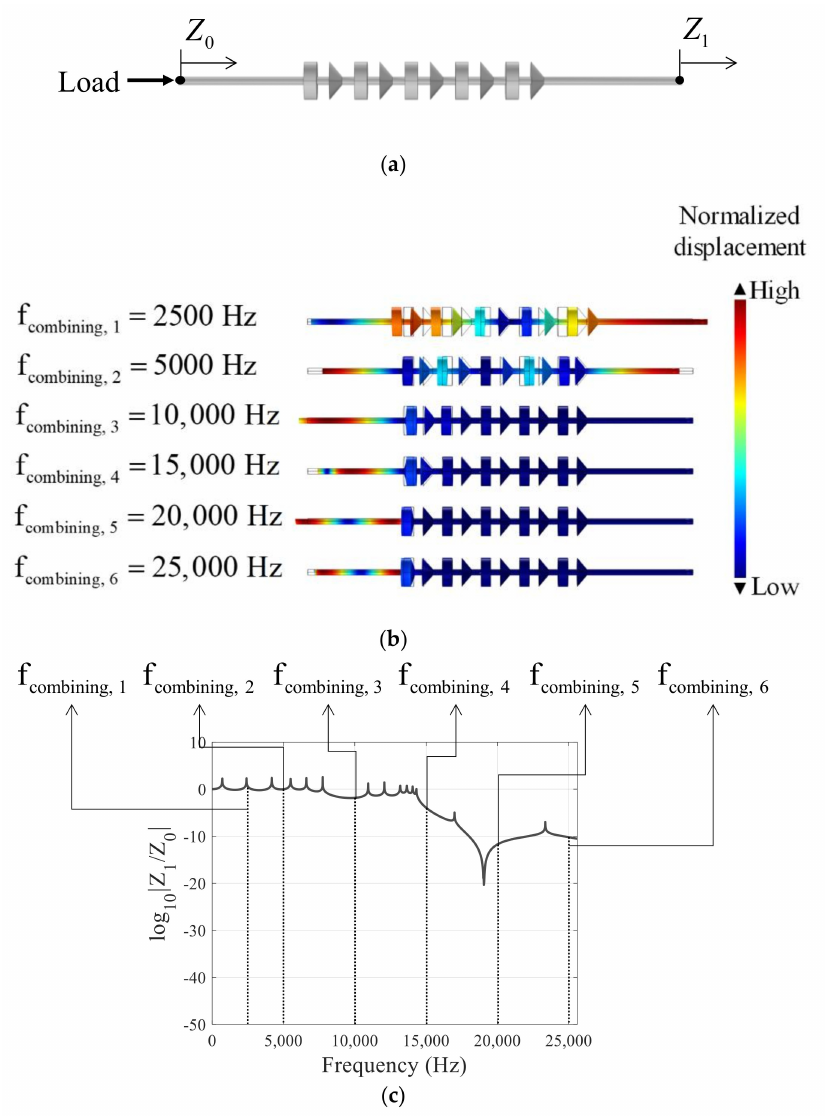
Figure 10. ( a ) Model of combining cylindrical and conical metamaterials, ( b ) the displacement at certain frequency and ( c ) the frequency responses ( r p = 0.03 m, h p = 0.02 m, s = 0.02 m, n = 5).